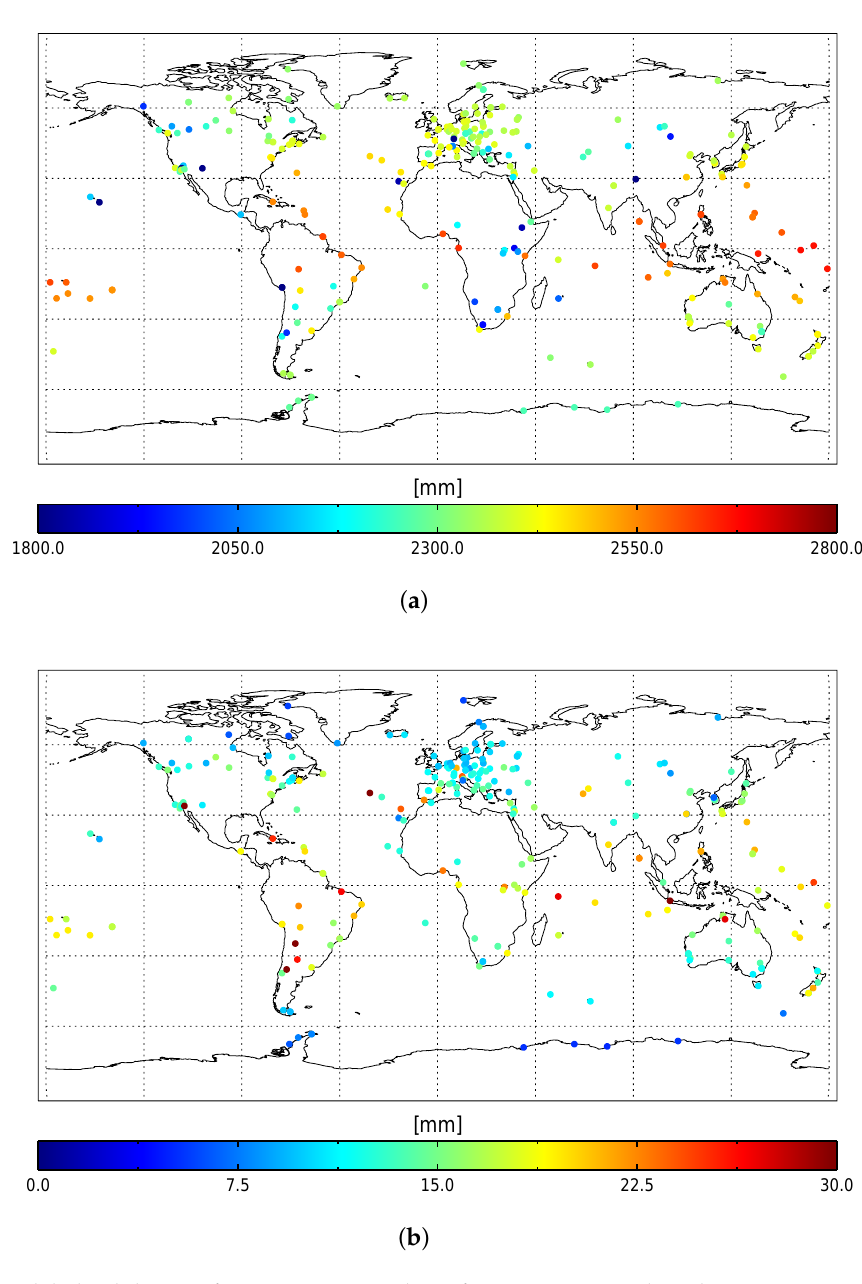
Figure 3. Global validation of ERA-Interim products from 2010 to 2015 based on 268 GPS stations of the IGS network: ( a ) mean value of the integrated ZPD; ( b ) standard deviation of the difference between the integrated ZPD and GPS